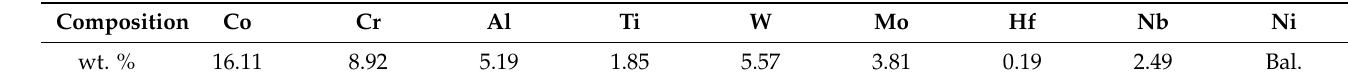
Table 1. Chemical composition of the studied P/M FGH97 superalloy (wt.